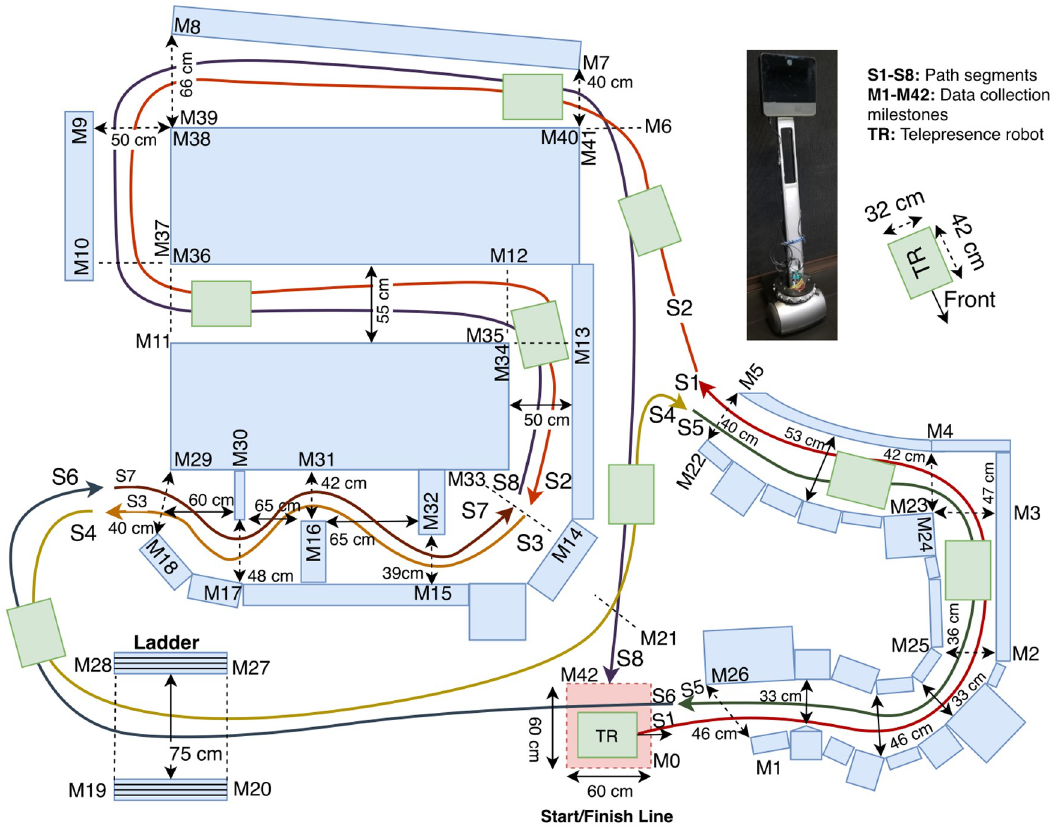
Fig 5. The obstacle course designed to evaluate TR maneuvering in dense environments. For clarity, only the distances for the most important parts of the path are shown in the figure. Dashed lines show the milestone lines. The colored lines correspond to the whole sequence of navigation (red ! orange ! yellow ! green ! dark blue ! brown ! light